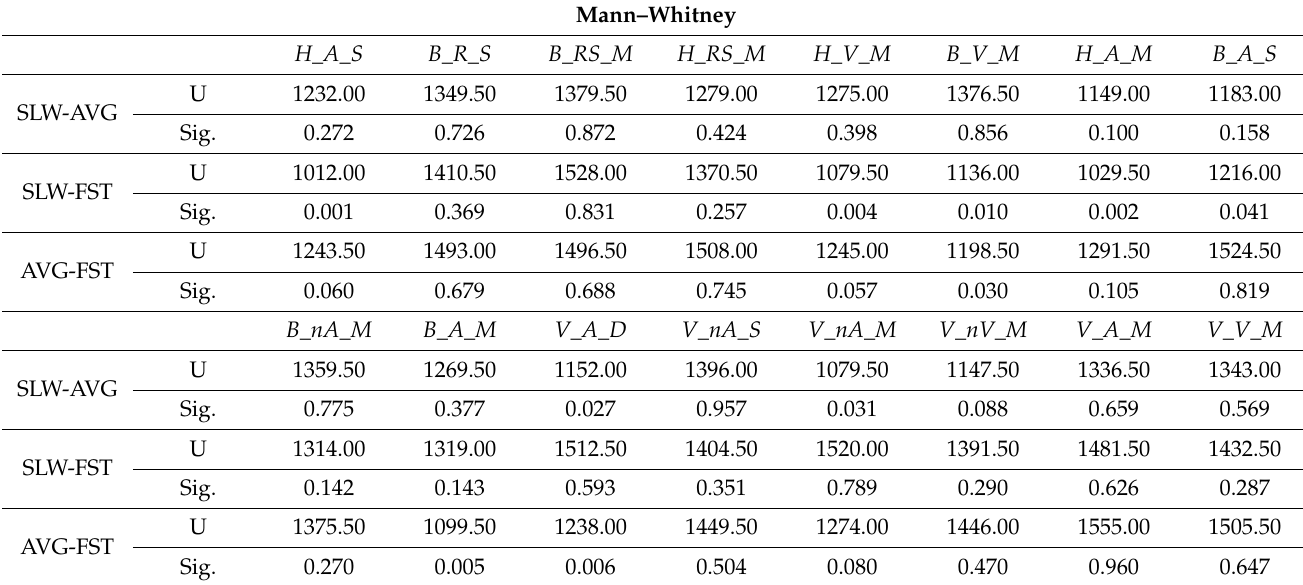
Table 5. The pairwise comparisons of the temporal structure of the reverse punch between the strikes classified as fast, average, and slow in relation to the achieved maximal hand